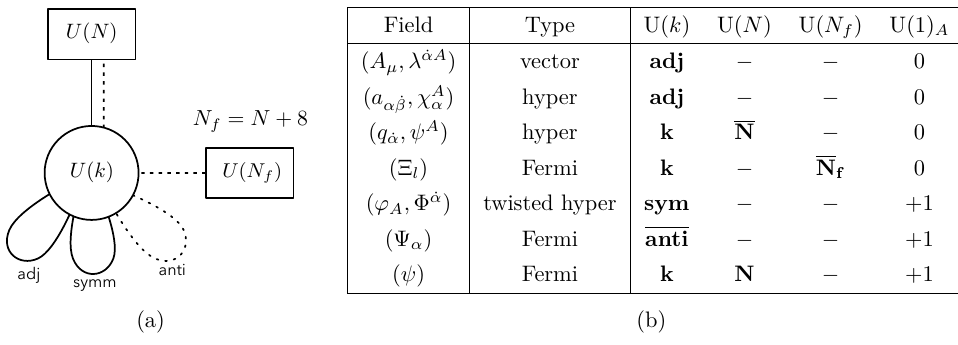
Figure 4. UV gauge theory on SU( N ) self-dual strings in the E-string Higgsing chain.